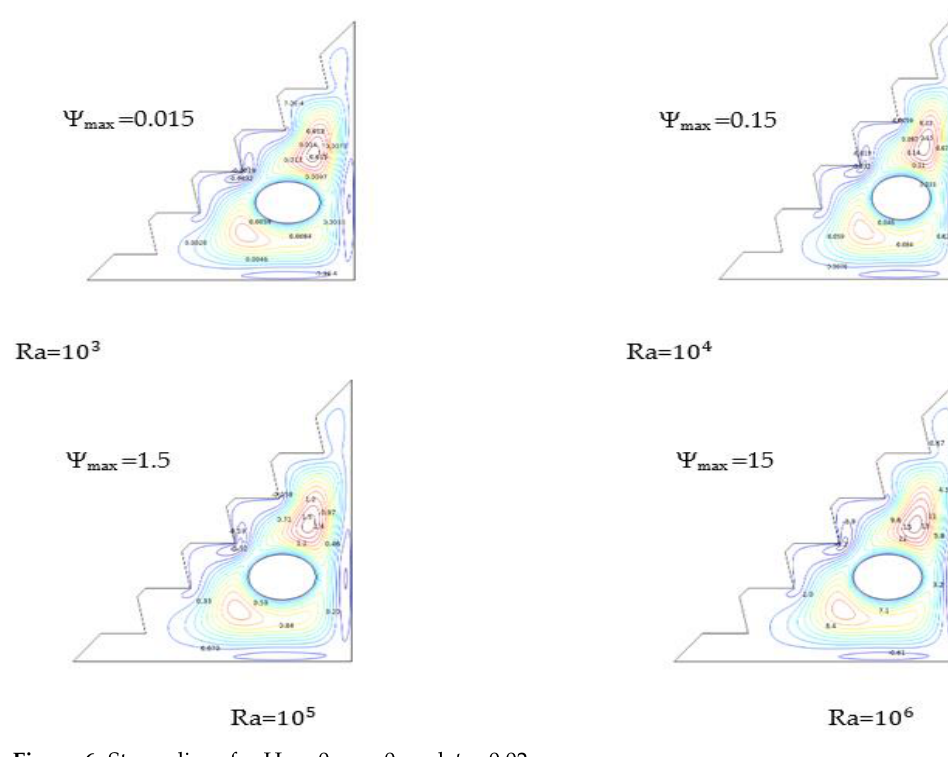
Figure 6. Streamlines for Ha = 0, w = 0, and ϕ = 0.02.